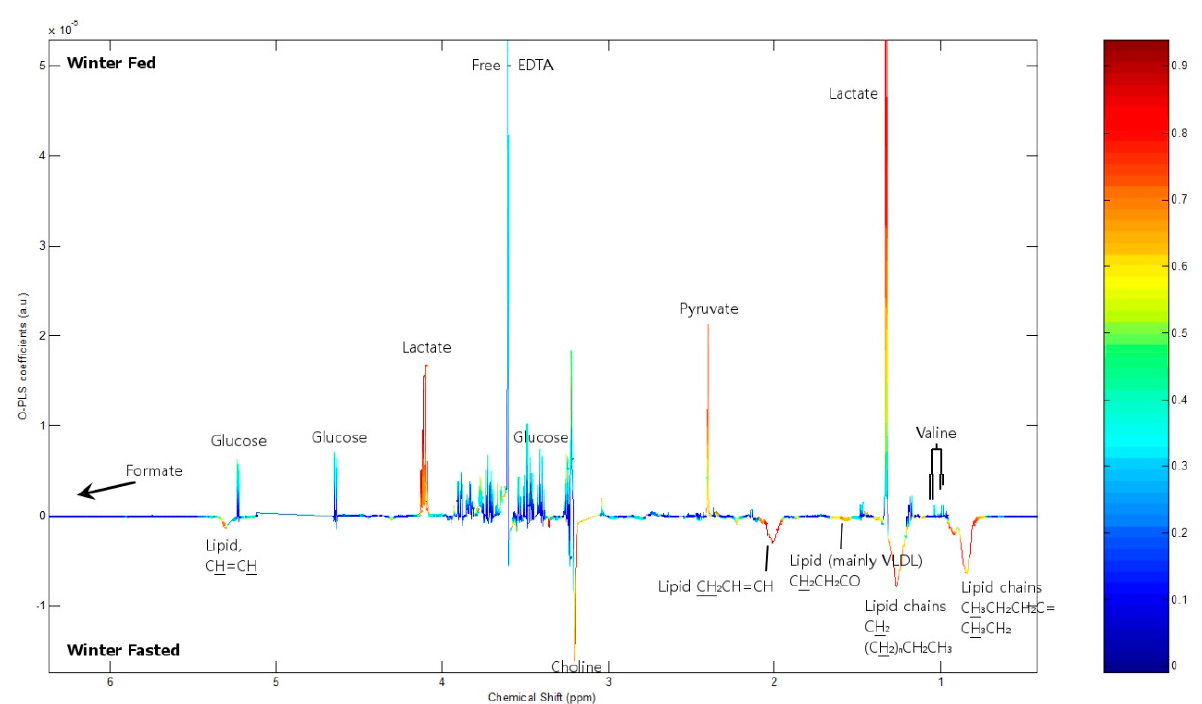
Figure 4. Loadings obtained by an OPLS-DA multivariate analysis on the NMR spectra comparing winter fed to winter fasted. The height of the peak represents the abundance of the metabolite in either group and the warmer coloring scheme (yellow, orange, red) indicate higher correlation value up to 1 within the group. The metabolite assignments are added in the Figure for visualization. Hyphenations in the Figure are EDTA, ethylenediaminetetraacetic acid and VLDL, very low-density lipoprotein.